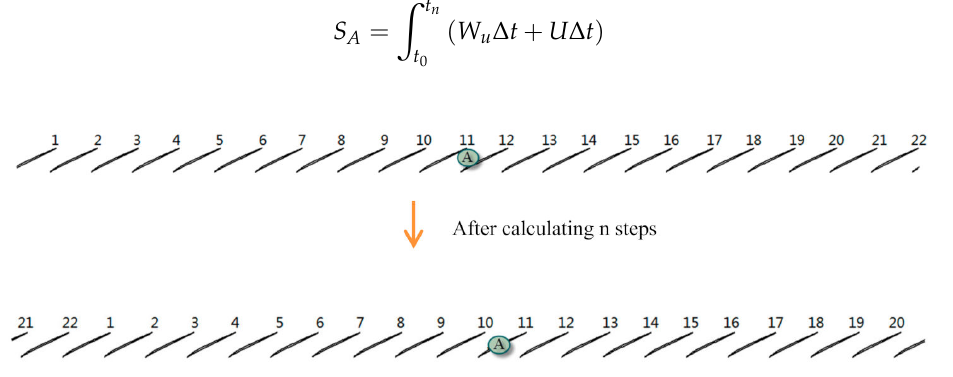
Figure 22. Changes in the computational domain of the rotor under unsteady